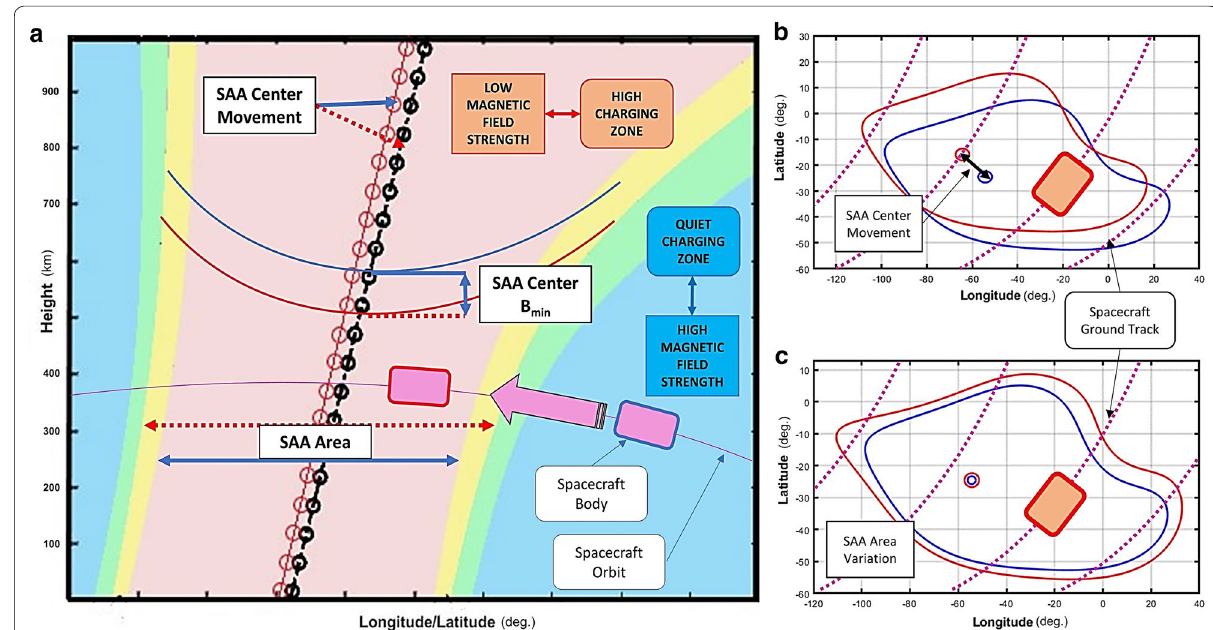
Fig. 1 SAA Parameters’ Illustration. The SAA variables are displayed in two different views. The contours in a are colored based on the energetic particle ( radiation) population (light red for the high population and light blue for the low population). b , c roughly demonstrate the movement = and the expansion of the SAA,